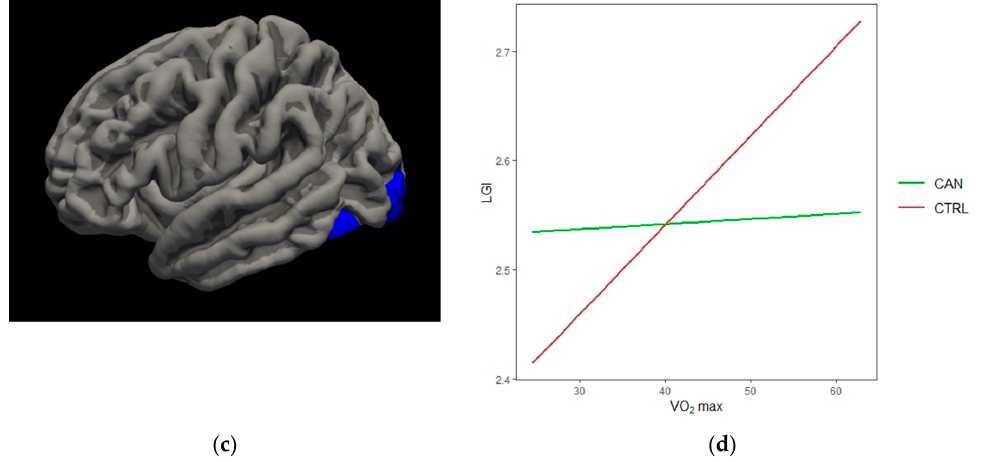
Figure 4. Cannabis*VO 2 Findings. ( a ) Medial view of significant interaction between VO 2 and cannabis group in left cuneus SA; ( b ) non-using controls demonstrated a positive relationship between VO 2 and increased area, whereas cannabis users demonstrated a negative relationship. ( c ) Lateral view of significant interaction between VO 2 and cannabis group in left lateral occipital LGI; ( d ) non-using controls demonstrated a positive relationship between VO 2 and increased LGI, whereas no trend was observed for cannabis users.